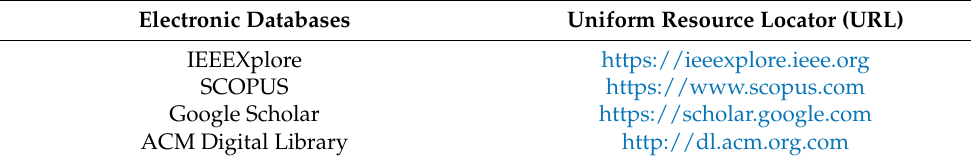
Table 3. Electronic databases used in automated search.